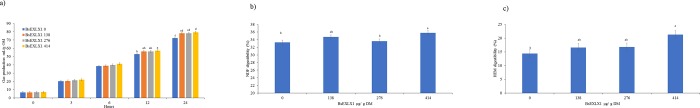
a, b and, c. Effect of dosing recombinant expansin-like protein (BsEXLX1) (μg/g DM) on a) cumulative gas production (mL/ g OM incubated) of a total mixed ration for dairy cows. b) In vitro digestibility of neutral detergent fiber (NDF) of a total mixed ration after 24 h incubation. c) In vitro digestibility of the hemicellulose fraction of a total mixed ration for dairy cows after 24 h incubation. Samples were incubated in triplicate and the experiment was repeated three times. Different letters on bars indicate differences (P < 0.05). For a and c polynomial contrasts showed a linear effect of increasing the dose in of BsEXLX1 (P < 0.01), whereas for b polynomial contrast showed a quadratic effect of increasing BsEXLX1. Error bars indicates SEM (Experiment 5).